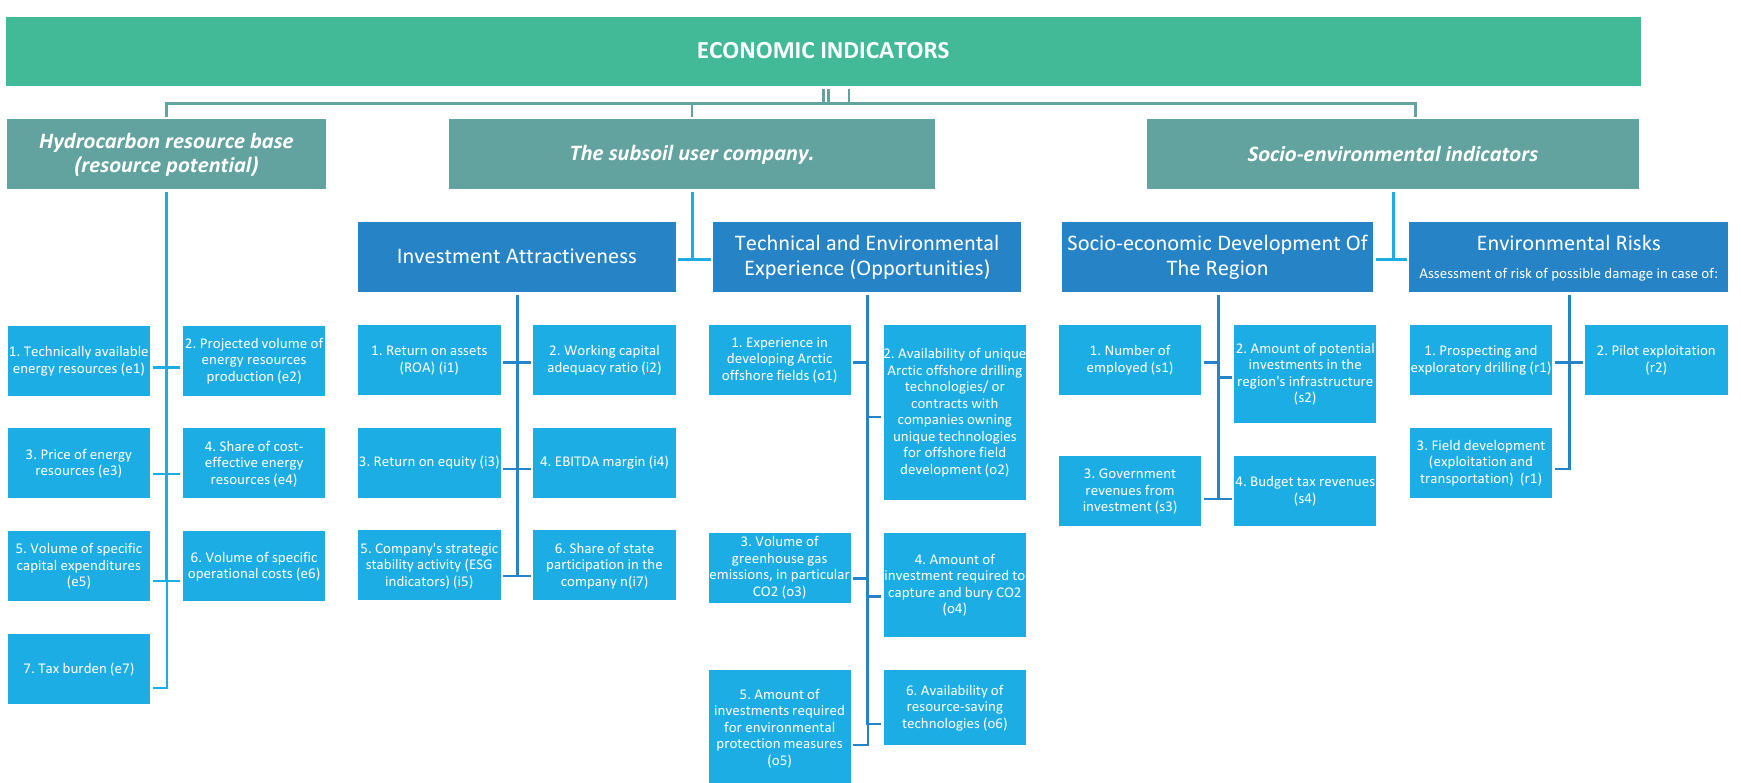
Figure A1. Classification of economic indicators for assessing the technical and economic potential of developing Arctic offshore oil and gas fields (Compiled by the authors).